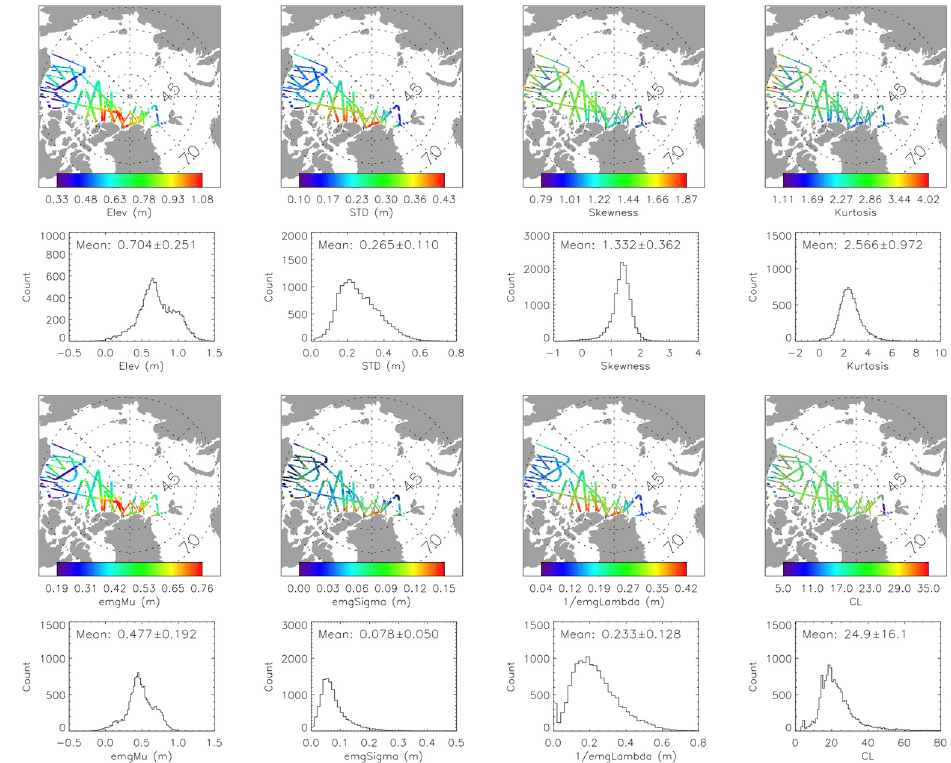
Figure 8. The mean elevation, standard deviation of elevation, skewness, kurtosis, µ e (emgMu), σ e (emgSigma), 1/ λ (emgLambda), and CL of the 1.5 km sections of 2014. Measurement noise is removed from the standard deviation of elevation.